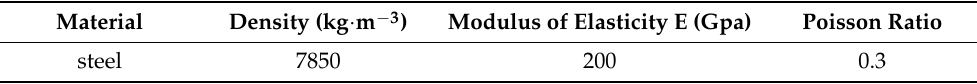
Figure 2. Vibration damping performance test platform with local oscillator cycle pipe. Table 2. The physical parameters of the periodic pipeline material. Table 2. The physical parameters of the periodic pipeline material.